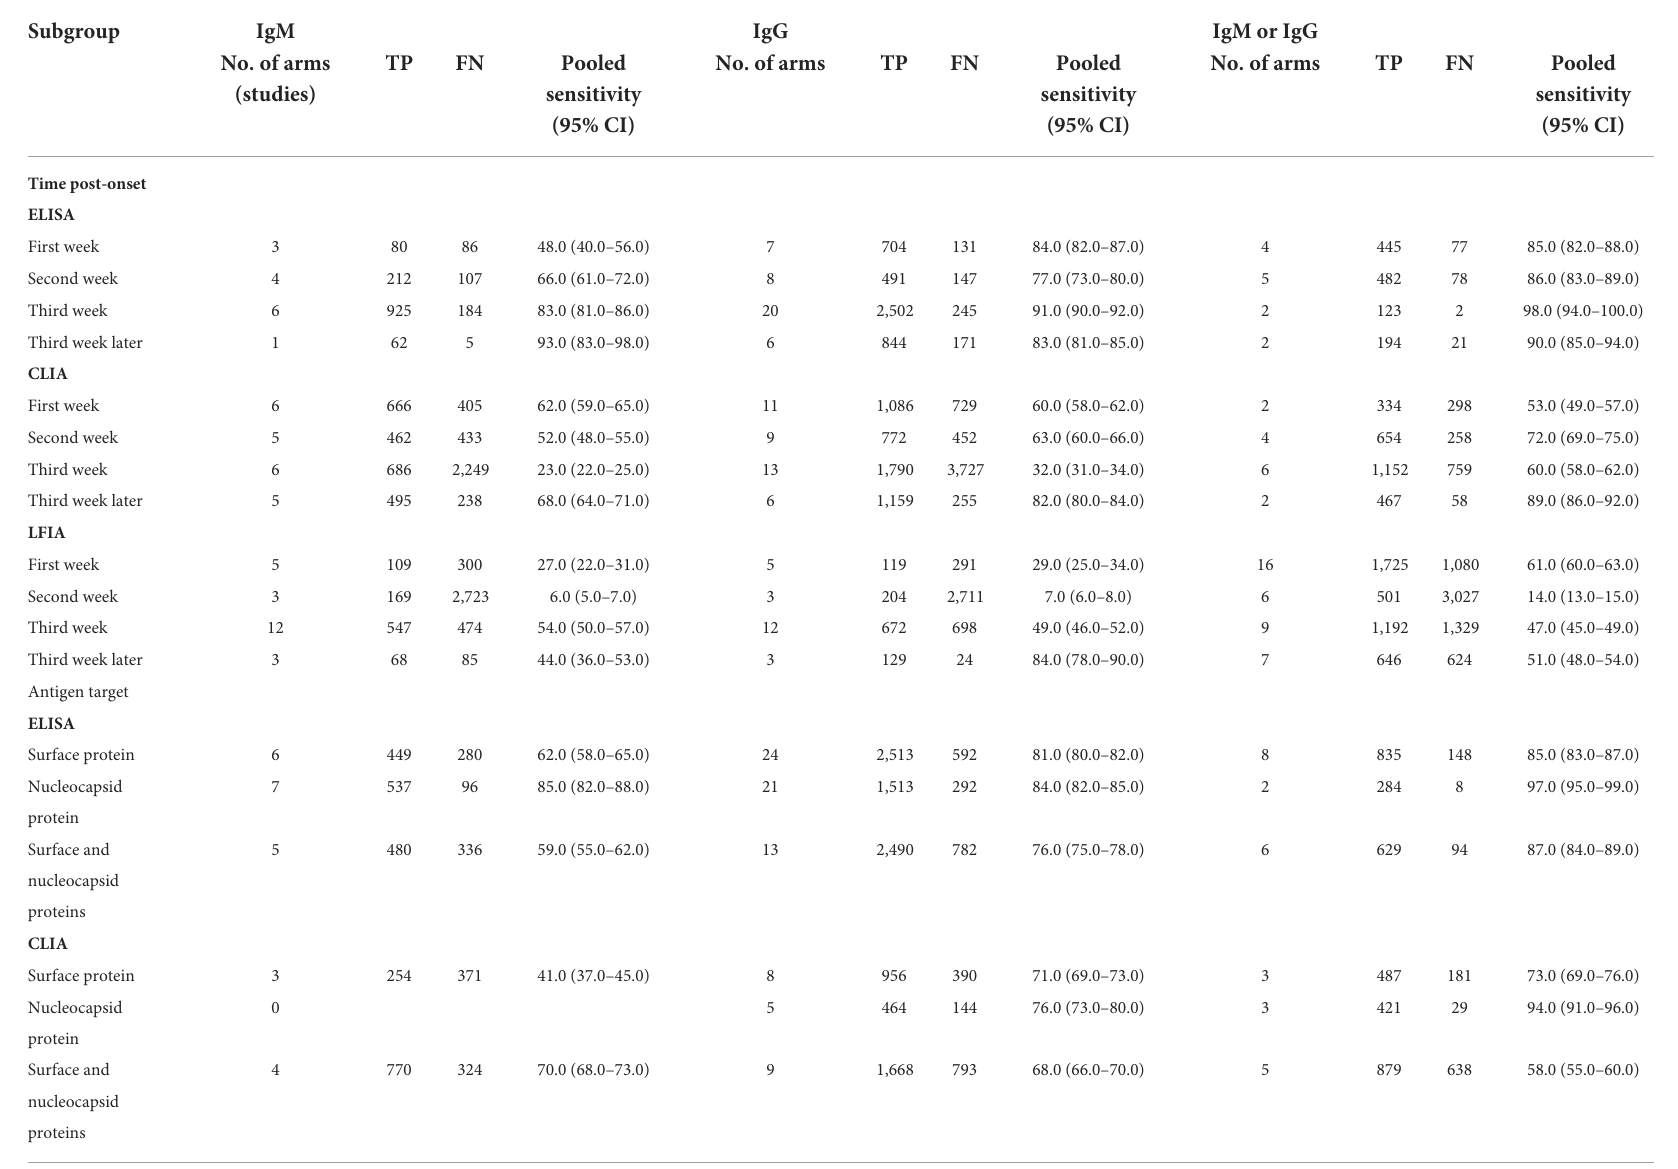
TABLE 4 Accuracy of COVID-19 serology tests stratified by potential sources of